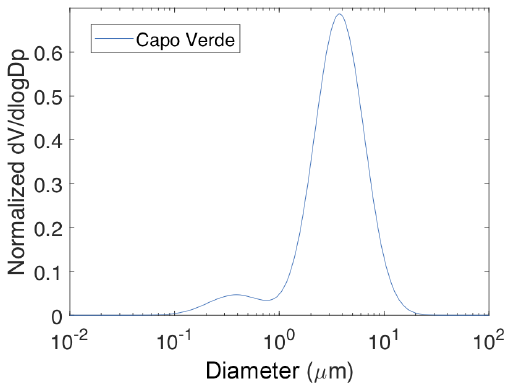
Figure A2. Average normalized volume size distribution for dust- dominated days in the Capo Verde